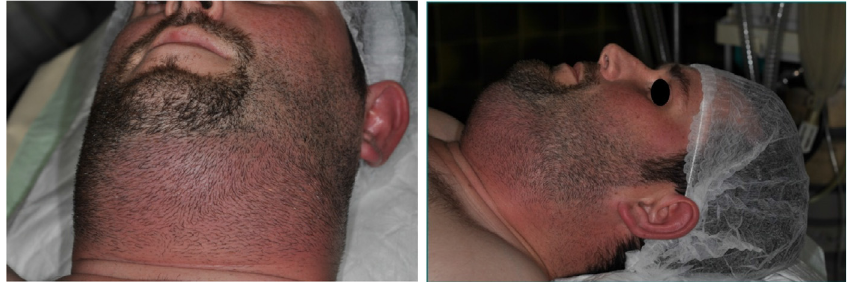
Fig. 1. Bilateral cervical swelling with local signs of intense in fl ammation.